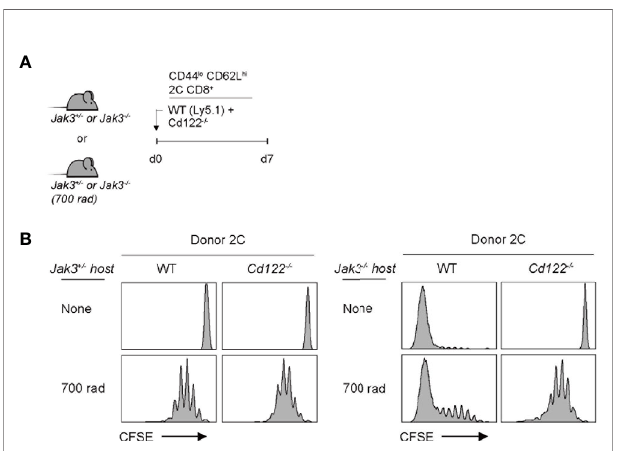
FIGURE 2 | Role of IL-2/IL-15R b expression for inducing donor T cell expansion in Jak3 − / − hosts. (A) Schematic diagram for adoptive transfer experiments. A mixture of FACS-puri fi ed CFSE-labeled naive WT (Ly5.1) and CD122(IL-2/IL-15R b )-de fi cient 2C CD8 + T cells was co-injected i.v. into either irradiated (700 rad) or unmanipulated Jak3 − / − and as a control Jak3 +/ − mice (0.5 × 10 6 cells for each donor per mouse; n = 2 – 3 mice). (B) Spleen cells of the recipient mice were analyzed on day 7 for CFSE dilution by fl ow cytometry.